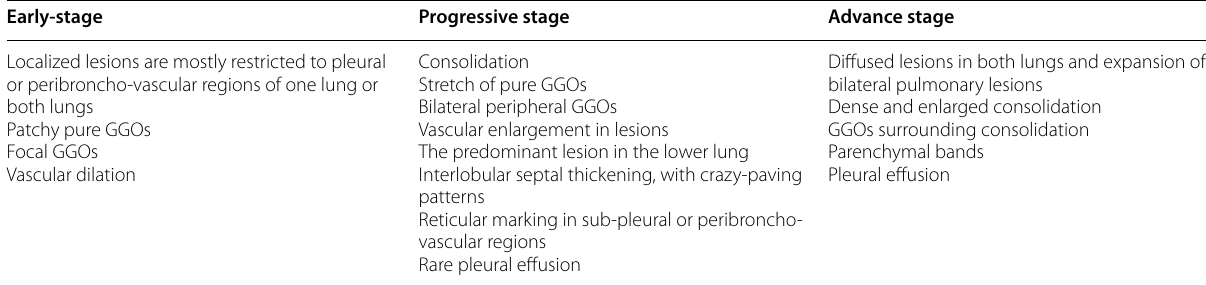
Table 3 CT image observations at different stages of the COVID-19 [49, 68] Early‑stage Progressive stage Advance stage Localized lesions are mostly restricted to pleural or peribroncho-vascular regions of one lung or both lungs Patchy pure GGOs Focal GGOs Vascular